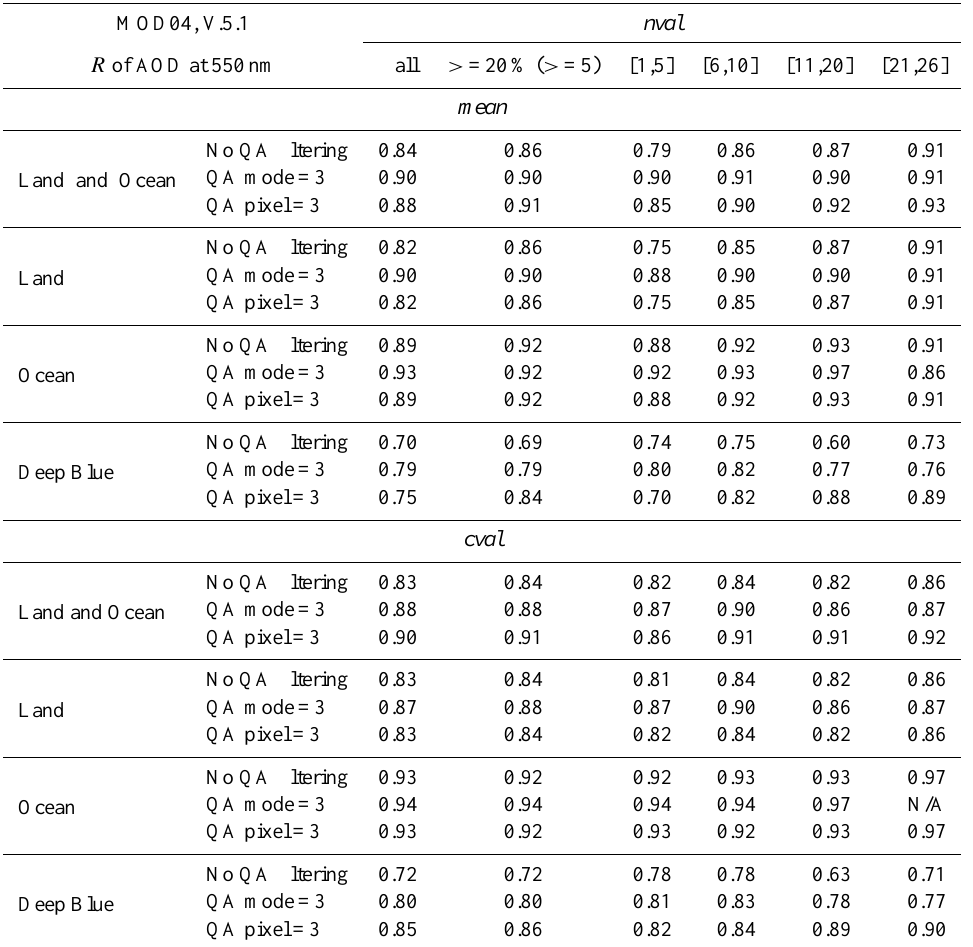
Table 3. Correlation coefficient ( R ) between mean values of AERONET AOD and Terra MODIS AOD at 550nm depending on different MODIS data screening scenarios, and also between cval (value of the central pixel in the sample) values of these two products. Factors considered for the screening include QA (Quality Assurance) flags of individual data pixels, mode of QA flags of all valid pixels in the sample, and nval (number of valid pixels in the sample). MODIS QA value of 3 indicates the data with the best quality. Correlation values for the medians of AOD are not shown as they are only marginally different from the reported values for the means of AOD. AERONET data was interpolated to 550nm and screened to have nval of at least